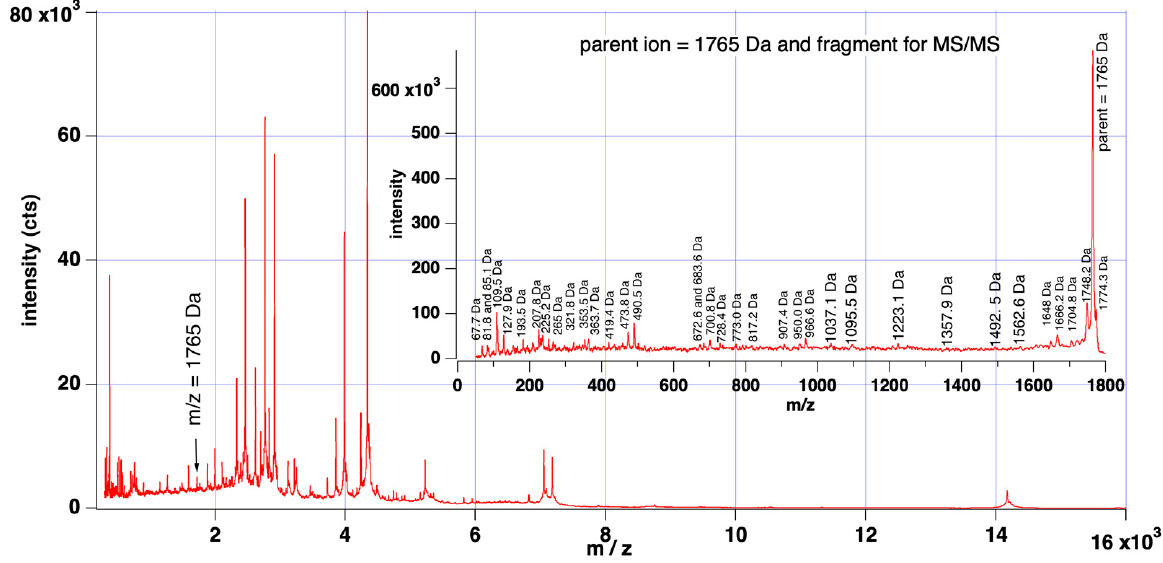
Figure 3. MALDI mass spectrum of milk from cows affected by mastitis. Inset is MALDI TOF/TOF spectrum of parent m/z = 1765 Da after fragmentation by collision-induced dissociation (CID). The peak at 1765 Da is indicated as a key ion in the decision tree.